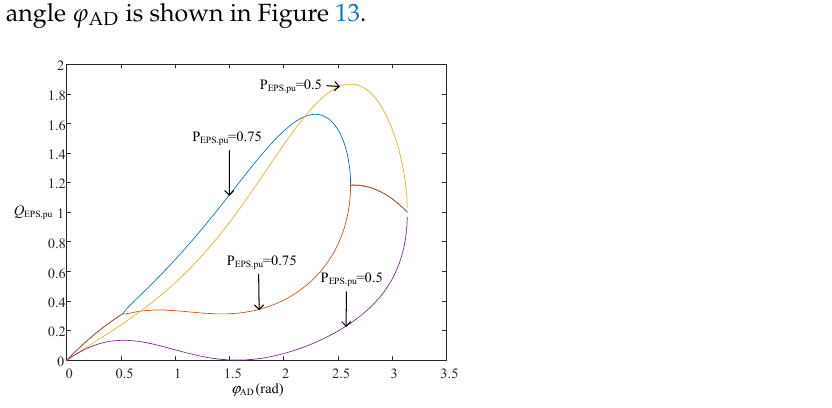
Figure 13. The relation curve between Q EPS.pu and the bridge phase-shift angle φ AD under different monoid values of active power.